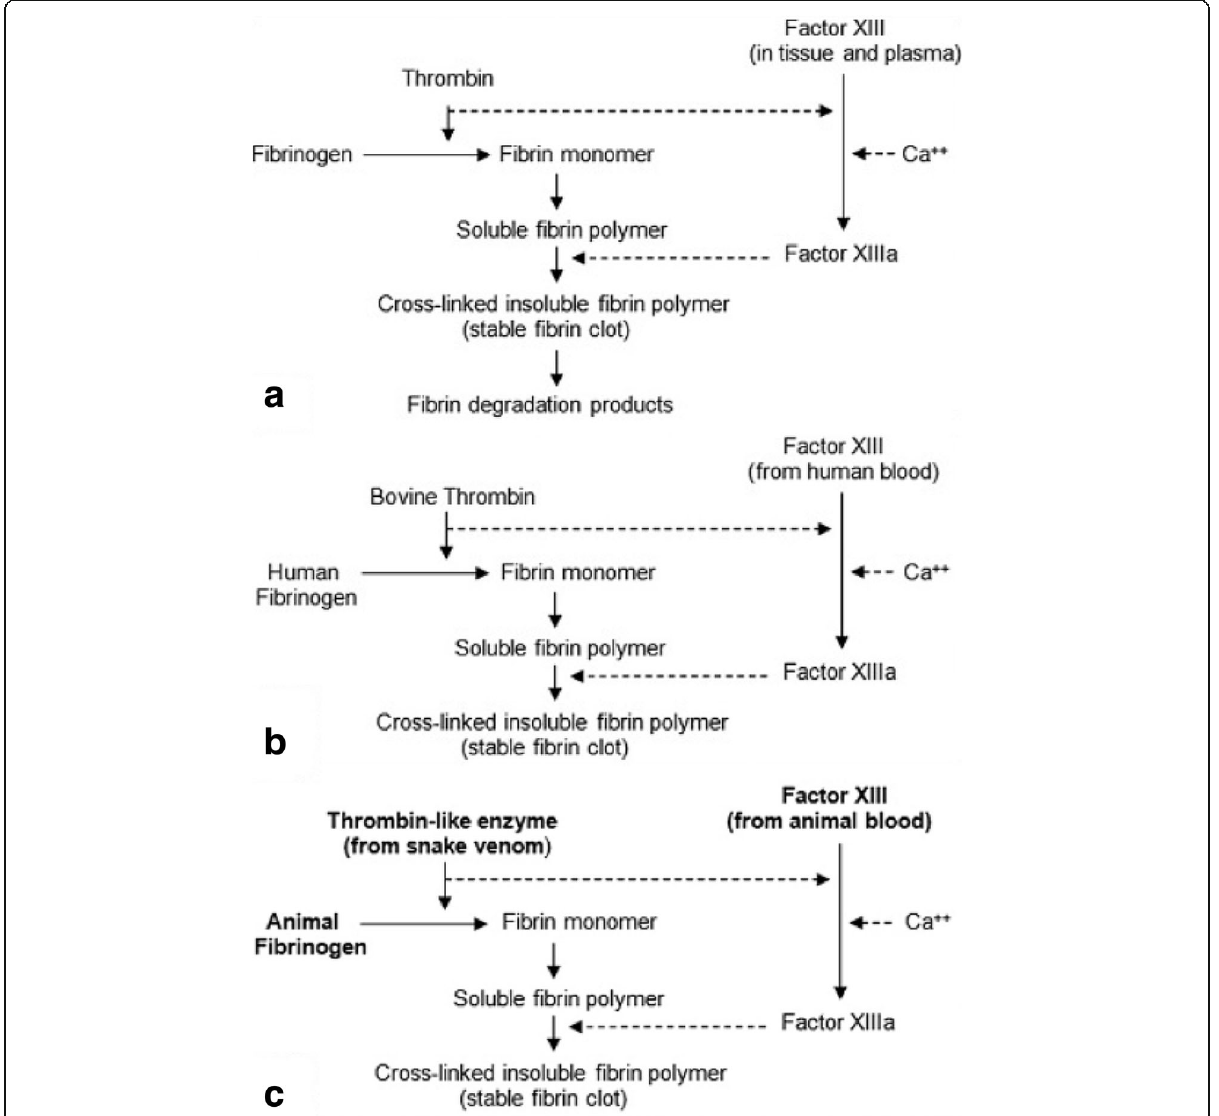
Fig. 1 a The final common pathway of the human blood-clotting cascade. b The effect of bovine thrombin on human fibrinogen. c The effect of a serine protease (thrombin-like enzyme) extracted from snake venom on animal fibrinogen forming a stable fibrin polymer. Reprinted from “ A new fibrin sealant from Crotalus durissus terrificus venom: applications in medicine ” by LC Barros et al., J Toxicol Environ Health B Crit Rev , 2009, 12(8), 553 – 71 [9]. Copyright by Taylor & Francis LLC (http://www.tandfonline.com). Reprinted with